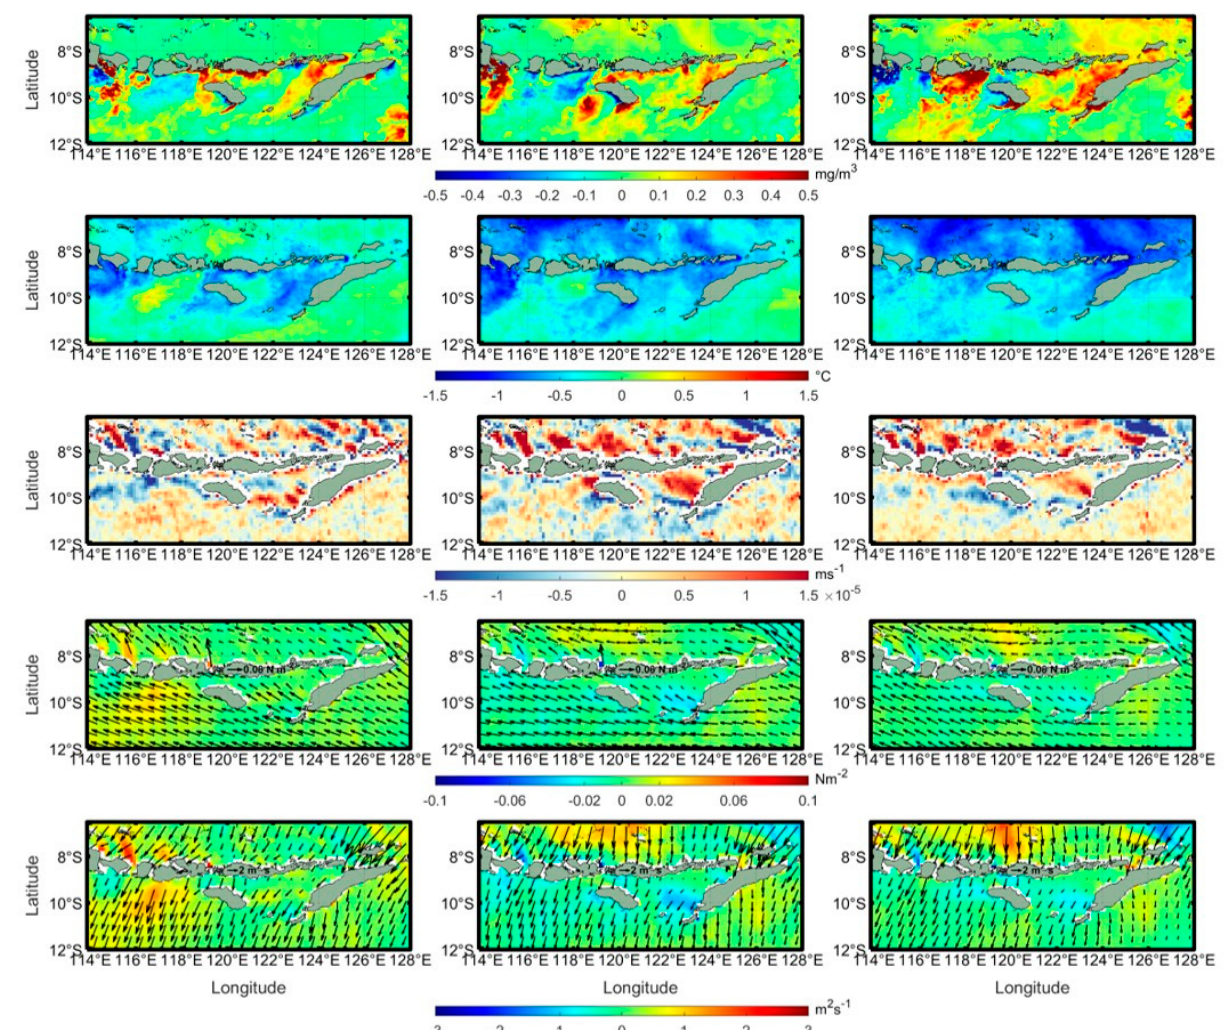
Figure 17. The anomalies of chlorophyll-a, sea surface temperature (SST), Ekman Pumping Velocity (EPV), wind stress, and Ekman Mass Transport (EMT) during the 2015 positive Indian Ocean Dipole (IOD) and El Nino (June–August from left to right), respectively (from top to bottom). We also noticed the same pattern during the 2010 negative IOD and La Nina. The negative anomaly of chl-a and the positive anomaly of SST were dominant along the southern coast of LSI. Additionally, weak wind stress and EMT were not evenly distributed in the same period. In June 2010, positive wind stress and EMT anomalies (0.02 Nm − 2 and 1.5 m 2 s − 1 ) were prominent along the Savu Sea and the eastern coast of East Nusa Tenggara and Timor, respectively. The positive wind stress and EMT anomalies occurred in July 2010 along the Savu Sea and the eastern coast of East Nusa Tenggara and Timor. As a result, the positive chl-a anomaly and the negative SST anomaly occurred in July 2010. Additionally, the negative wind stress and EMT anomalies occurred along the coast from Java to Lombok in July 2010, which was also in line with the negative chl-a anomaly and the positive SST anomaly. Furthermore, the spatial distribution of the positive EPV anomaly, which indicates downwelling off the southern coast of Bali to Sumbawa, was more prominent. As a consequence, positive SST and negative chl-a anomalies predominates in these